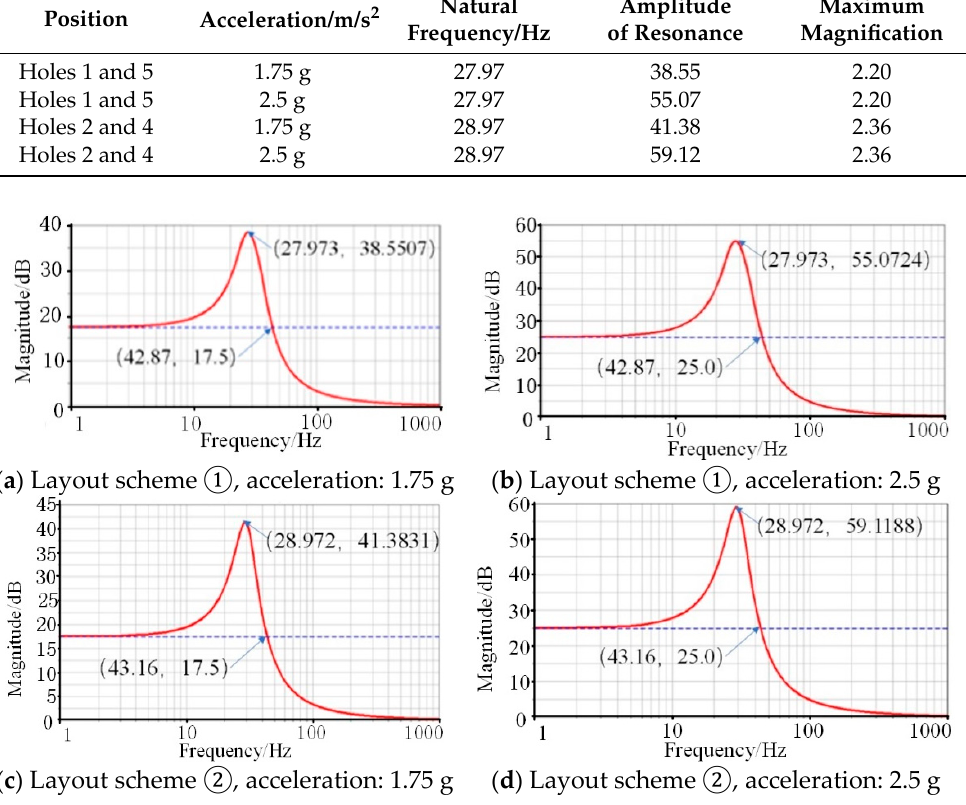
Figure 9. The frequency-response curve of the asymmetric distribution of vibration isolators. Table 3. Frequency-response results.